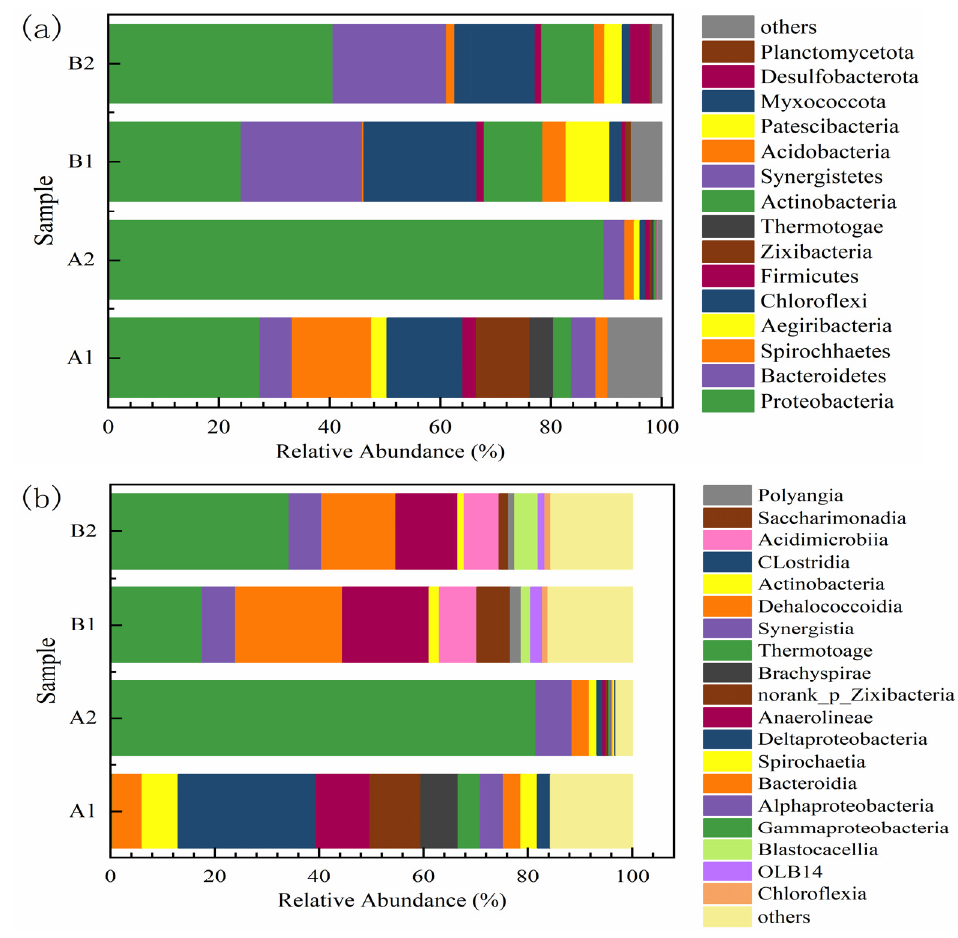
Figure 4. Community structure analysis of the microbial samples at the ( a ) phylum and ( b ) class